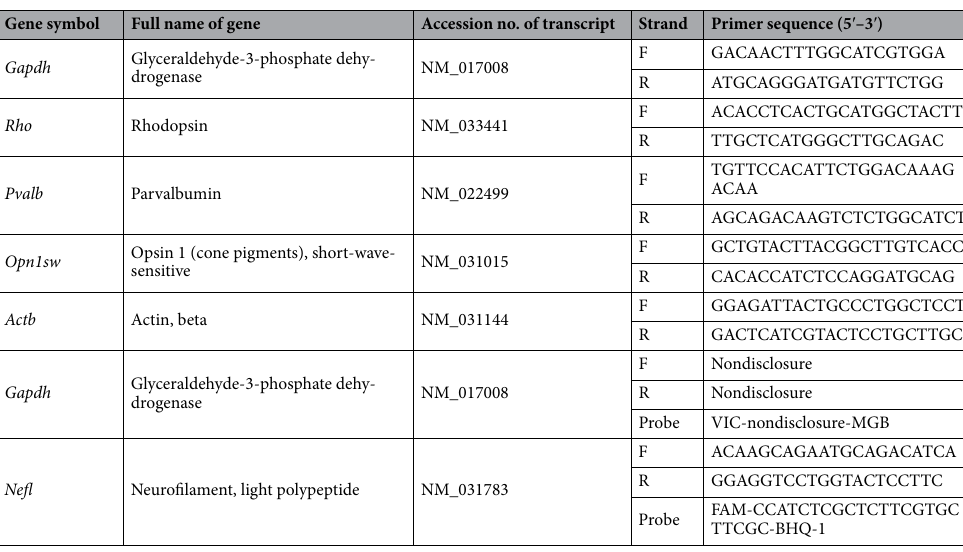
Table 1. Transcript and primer information for quantitative real-time PCR. F forward, R